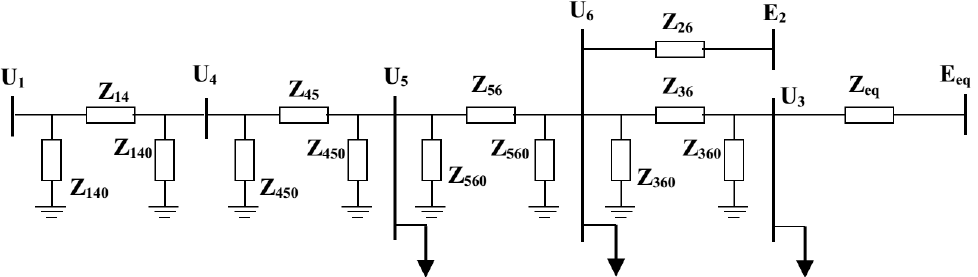
Figure 5. Equivalent diagram of the six bus power system.